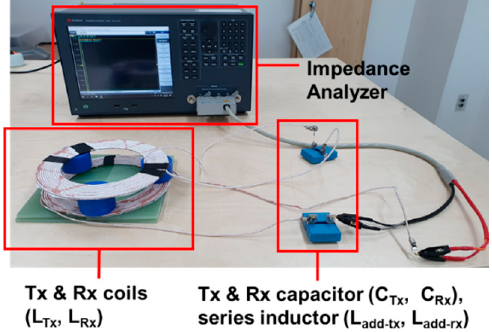
Figure 21. Input impedance measurement using an impedance analyzer.